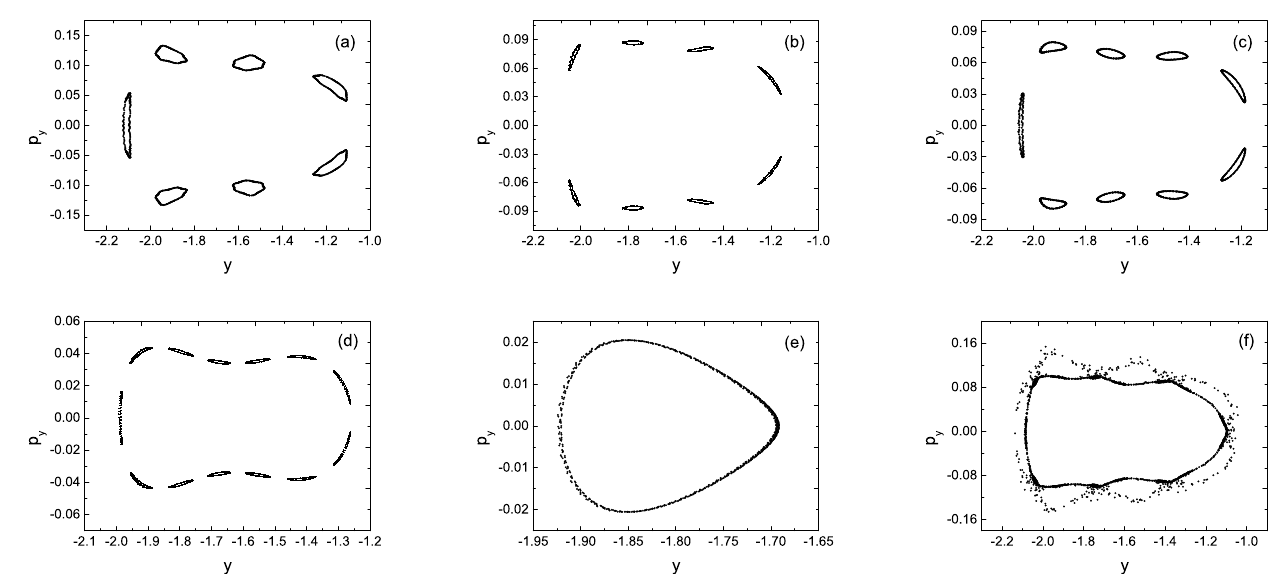
Figure 6. Phase-space structures described by N4P with the larger time step τ = 0.1 solving several orbits, which have only different initial values y with different starting values p x . ( a ) y = − 2.10, ( b ) y = − 2.08, ( c ) y = − 2.06, ( d ) y = − 1.99, ( e ) y = − 1.6, and ( f ) y = − 1.103. There are regular many-islands tori in ( a – d ). Only one single torus exists in ( e ). A chaotic many-islands orbit is given in ( f ). All the dynamical structures are physically performed by N4.